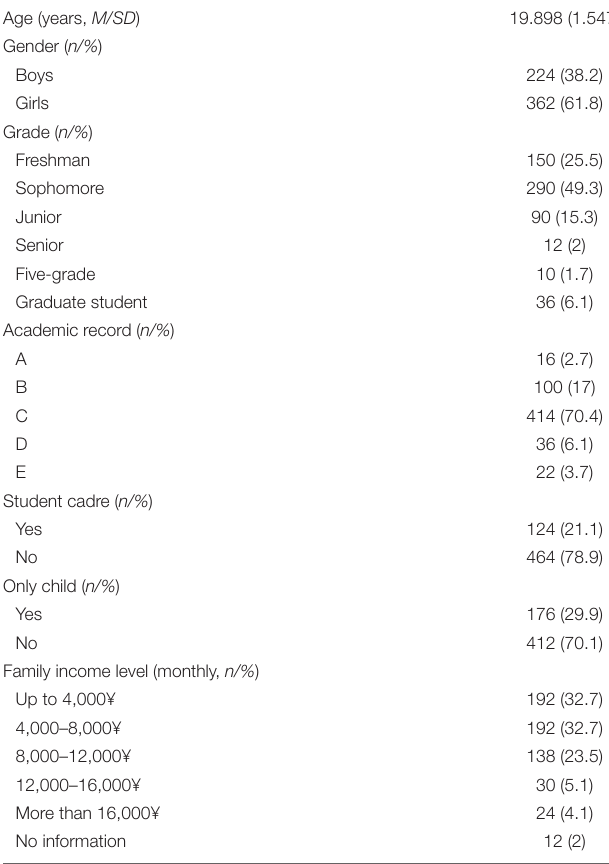
TABLE 1 | Sociodemographic characteristics of the sample ( n =